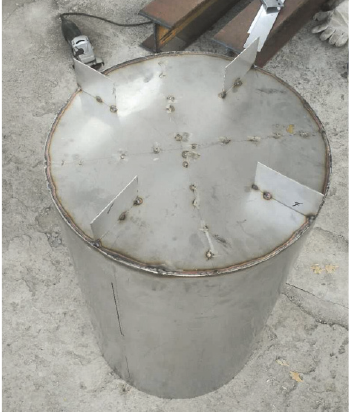
Figure 2: A photo for the auxiliary support structure.